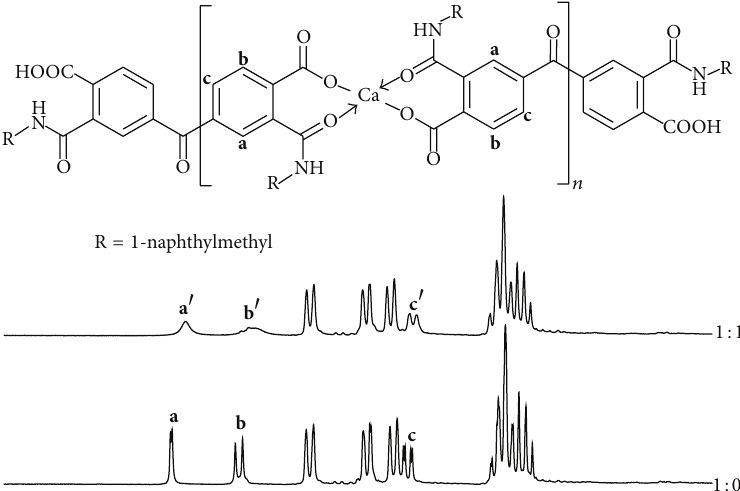
Figure 3: NMR titration of 3N with Ca 2+ ions in DMSO- 𝑑 6